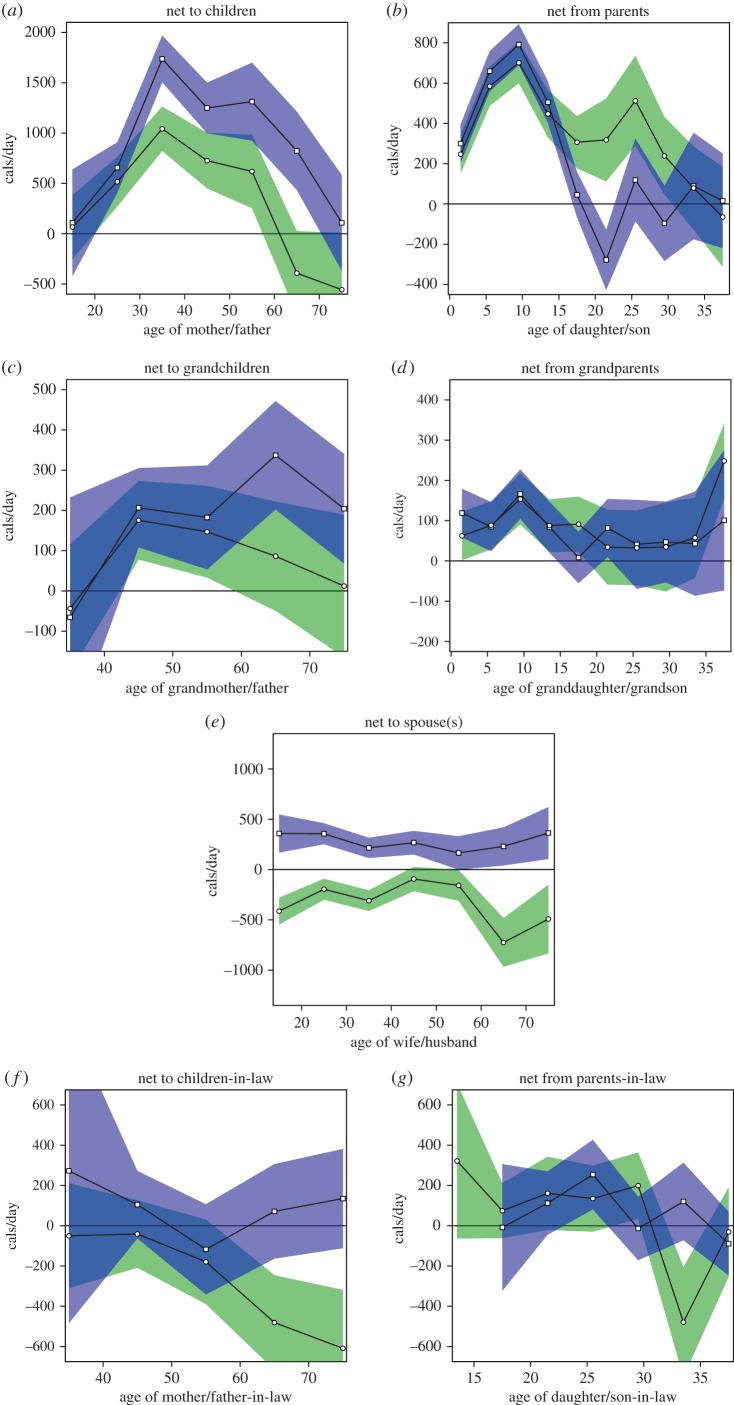
Net transfers of food as a function of donor and recipient age and sex. Means and standard errors are showed in green for females and purple for males. (a) Net from a focal mother/father to all children. (b) Net to a focal daughter/son from all parents. (c) Net from a focal grandmother/grandfather to all grandchildren. (d) Net to a focal granddaughter/grandson from all grandparents. (e) Net from a focal wife/husband to her/his spouse (or spouses). (f) Net from a focal mother/father-in-law to all children-in-law. (g) Net to a focal daughter/son-in-law from all parents-in-law. Values are derived from electronic supplementary material, tables E1–E7. Note that the y-axis varies depending on the scale of the net transfer values, and that transfers from mothers to offspring do not include contributions through lactation.